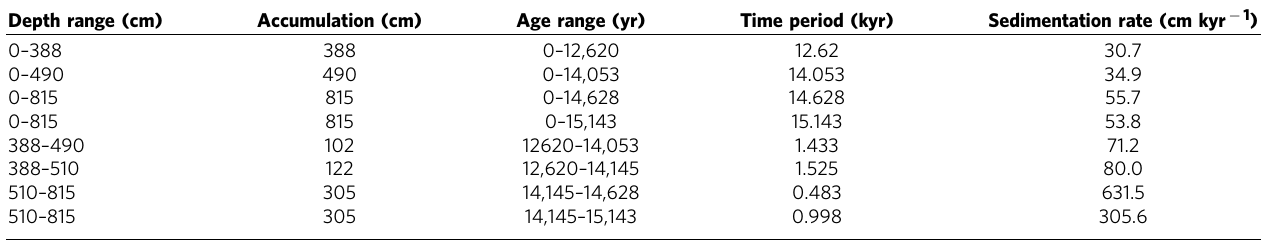
Table 2 | Calculated sedimentation rates for dated intervals in core GC666, from Royal Bay Trough. Depth range